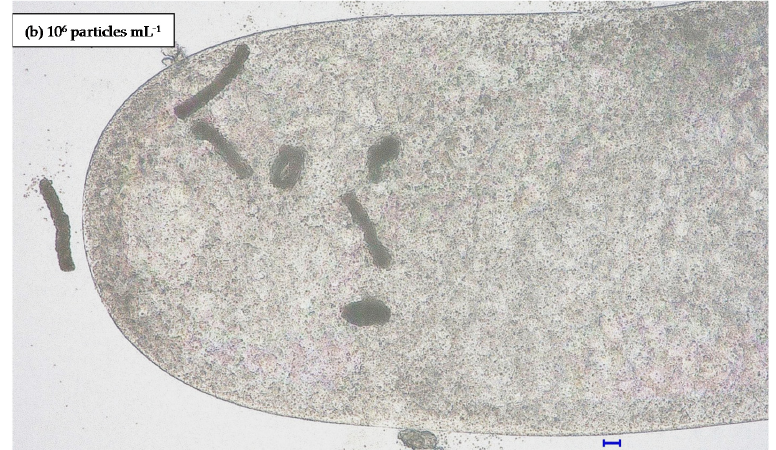
Figure 4. Food vacuoles formed in S. ambiguum in the PS suspension with a concentration of ( a ) 10 5 and ( b ) 10 6 particles mL –1 . Blue bar represents 10 μ m.